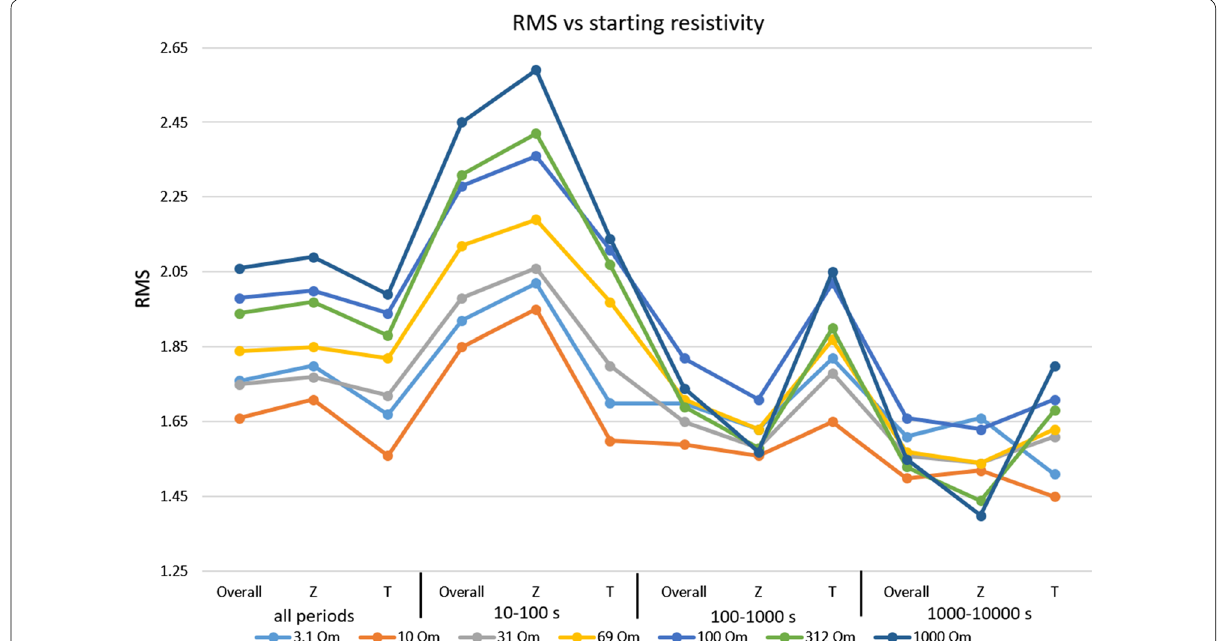
Fig. 7 The RMS, KSU (divided by ten for plotting purposes) and the RMS variance (left vertical axis) and the starting RMS (right vertical axis) for models with starting resistivity for seven different inversions with differing starting half-spaces, 3, 10, 31, 69, 100, 316 and 1000 (cid:31) m